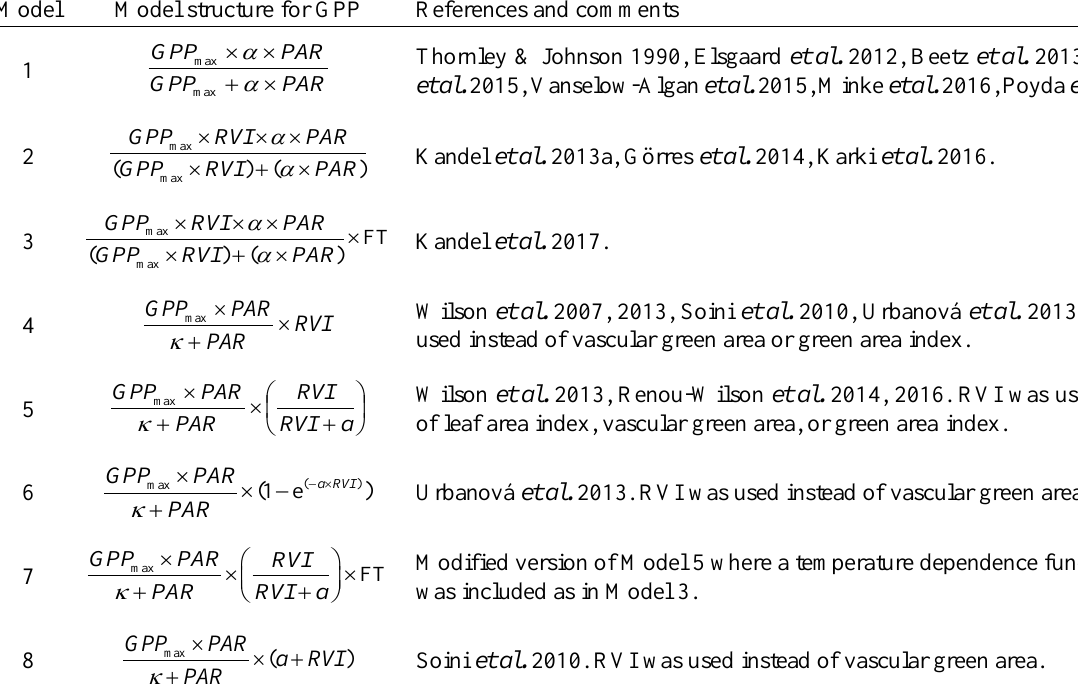
Table 2. Gross primary production (GPP) models adapted or modified from previous studies and used with the present dataset. Model Model structure for